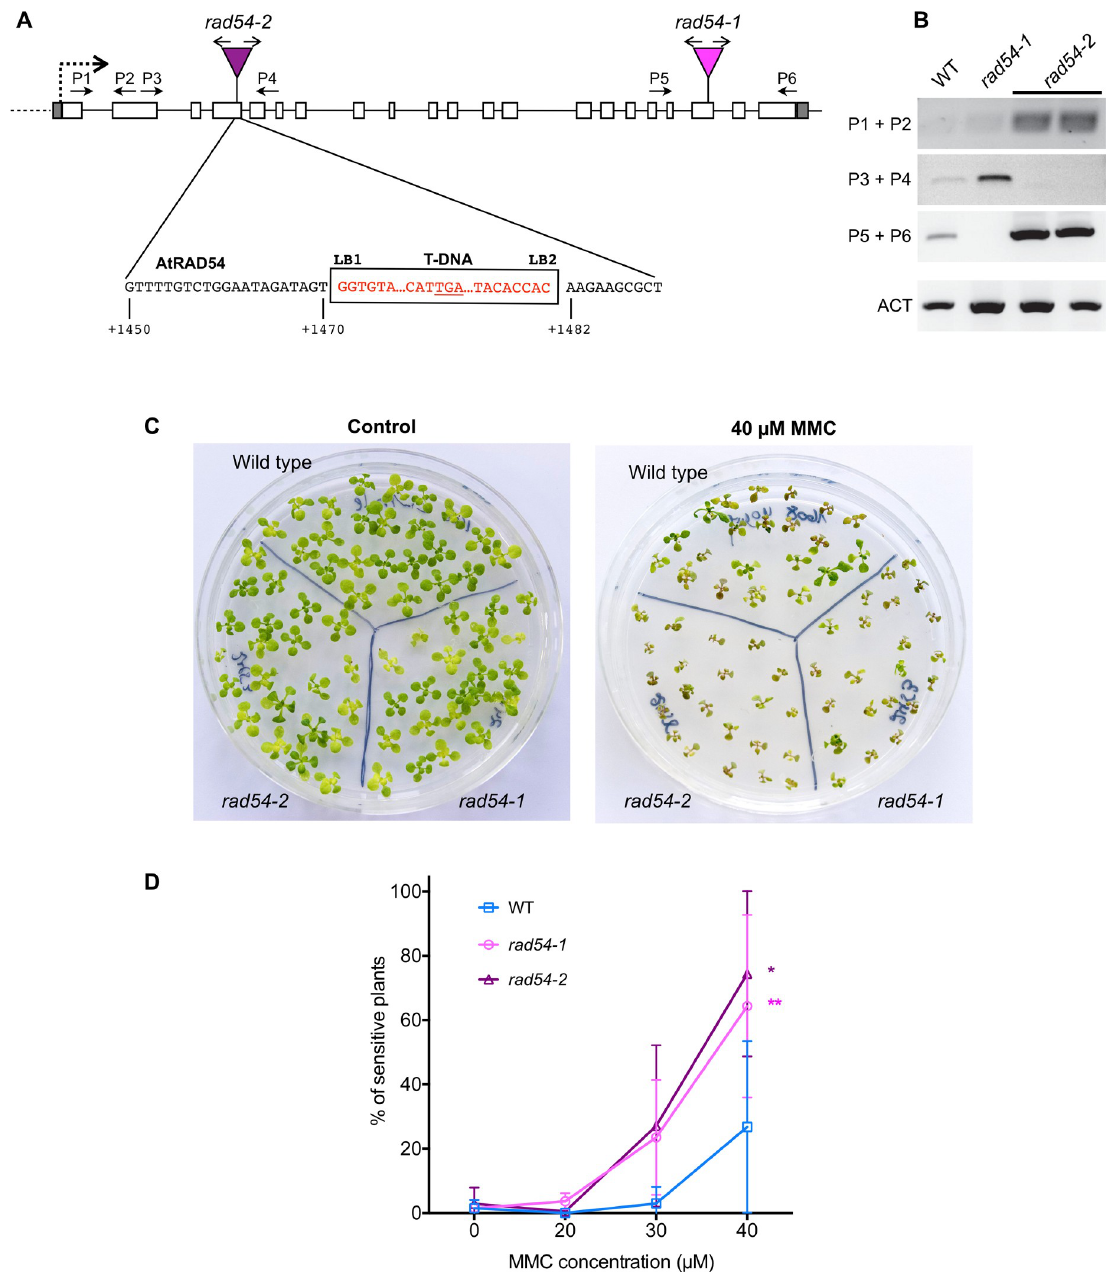
Fig 1. Characterisation of rad54-2 T-DNA insertion mutant and sensitivity to MMC. (A) Structure of AtRAD54 (At3g19210) and the rad54-1 and rad54-2 T-DNA insertion mutant alleles. Boxes show exons (unfilled) and 5’ and 3’UTRs (grey fill). The positions of the T-DNA insertions in the two alleles (inverted triangles) is indicated, with arrows above showing orientation of the left borders, and the sequences of the rad54-2 T-DNA/chromosome junctions below. The rad54-2 T-DNA insertion is flanked by two left borders (LB1, LB2) and accompanied by a 11 bp deletion in exon 4. An in-frame TGA STOP codon in rad54-2 is underlined. Numbering under the sequences is relative to the RAD54 start codon. (B) RT-PCR analyses of transcripts of rad54-1 and rad54-2 . Amplification of the actin transcript (ACT) was used as a control for RT-PCR. Positions and orientations of the PCR primers are shown on the diagrams. (C-D) Sensitivity of rad54-1 and rad54-2 plants to MMC. (C) Two-week-old seedlings grown without, or with 40 μ M MMC are shown. (D) Sensitivity of the seedlings was scored after 2 weeks (see Materials and Methods) and the percentages of sensitive plants (plants with 3 true leaves or less) are shown. Symbols are mean ± SD of at least 3 independent experiments with � 25 seedlings per genotype per experiment. ( � p < 0.05 and �� p < 0.005; paired two-tailed t-test).